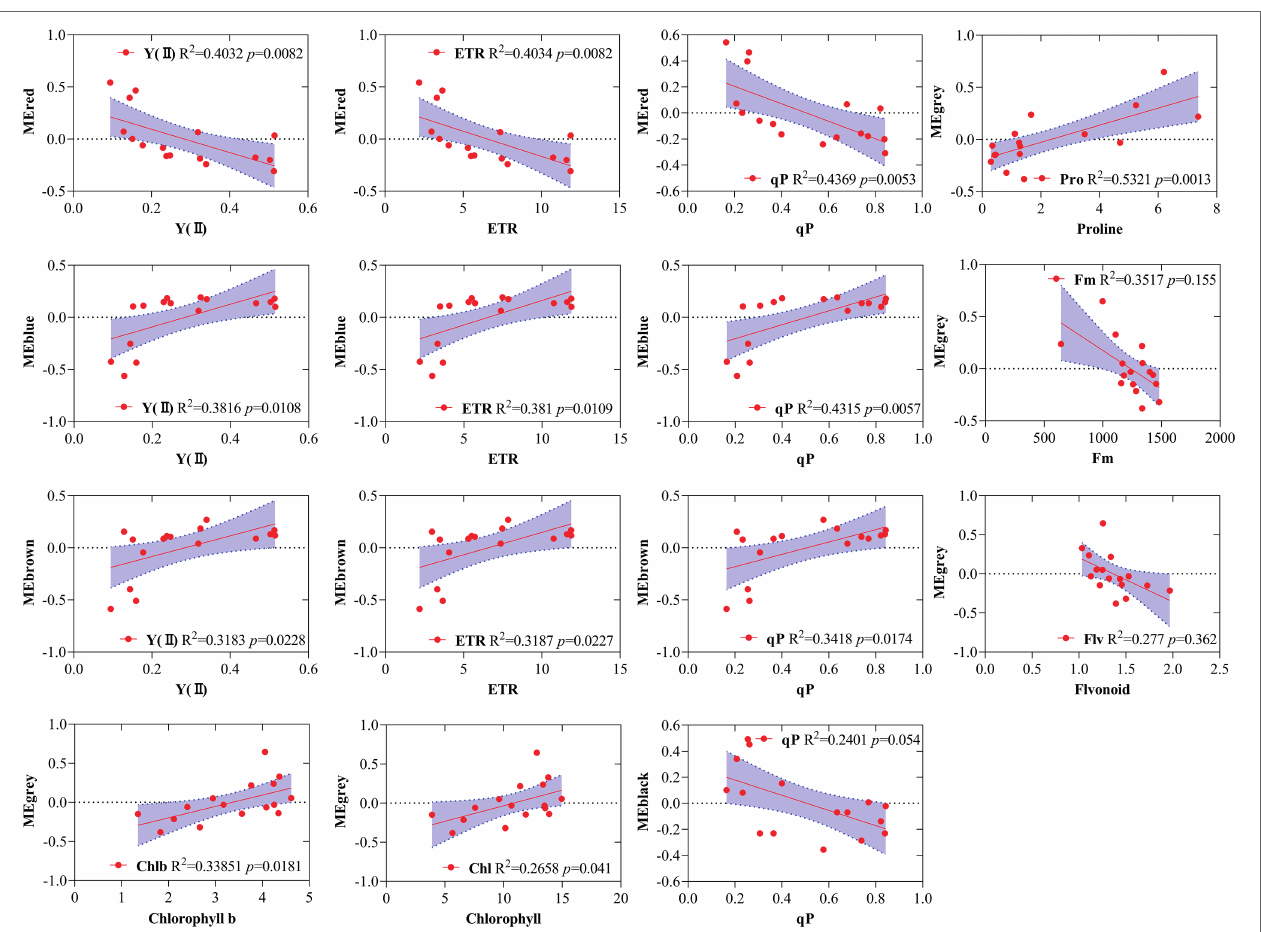
FIGURE 6 | Correlations between specific gene module eigen gene values (first principle component as a representative of the entire module) and corresponding physiological and biochemical indicators for MEred, MEblue, MEbrown, MEgrey. The red line indicates the regression line and lavender shading indicates the 95% confidence